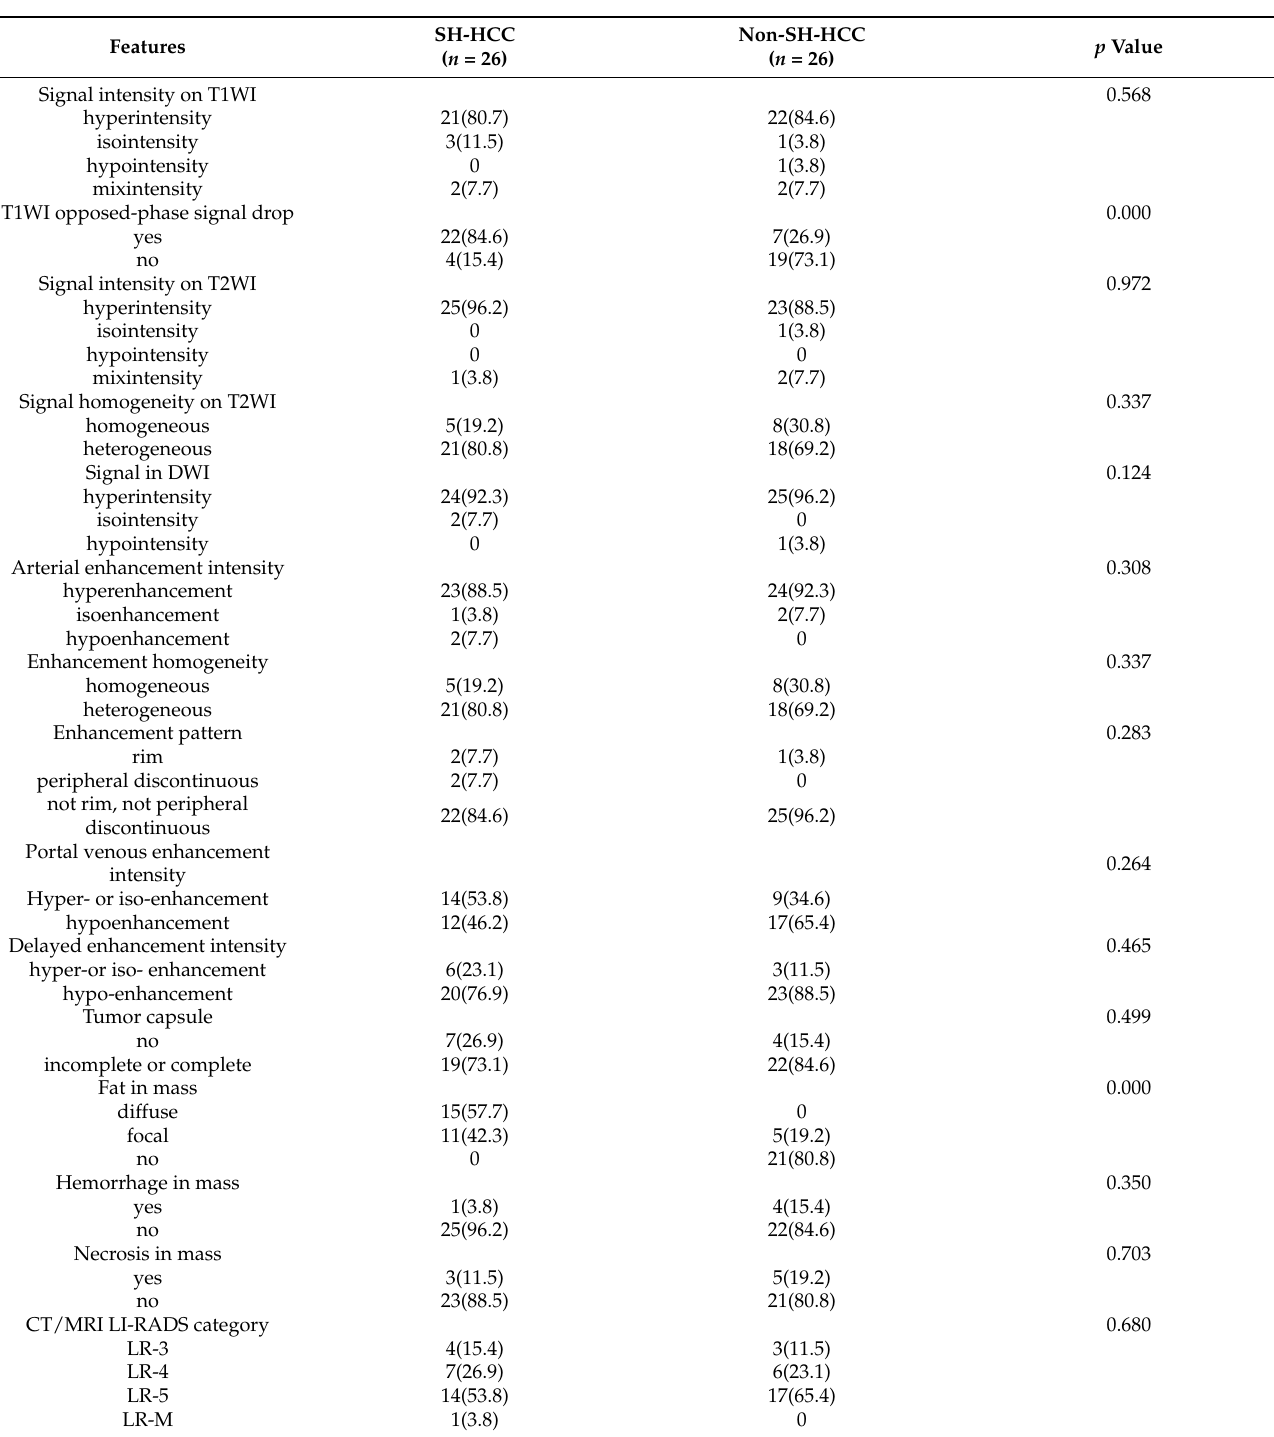
Table 3. The morphologic and enhancement features of SH-HCCs and non-SH-HCCs as seen via MRI